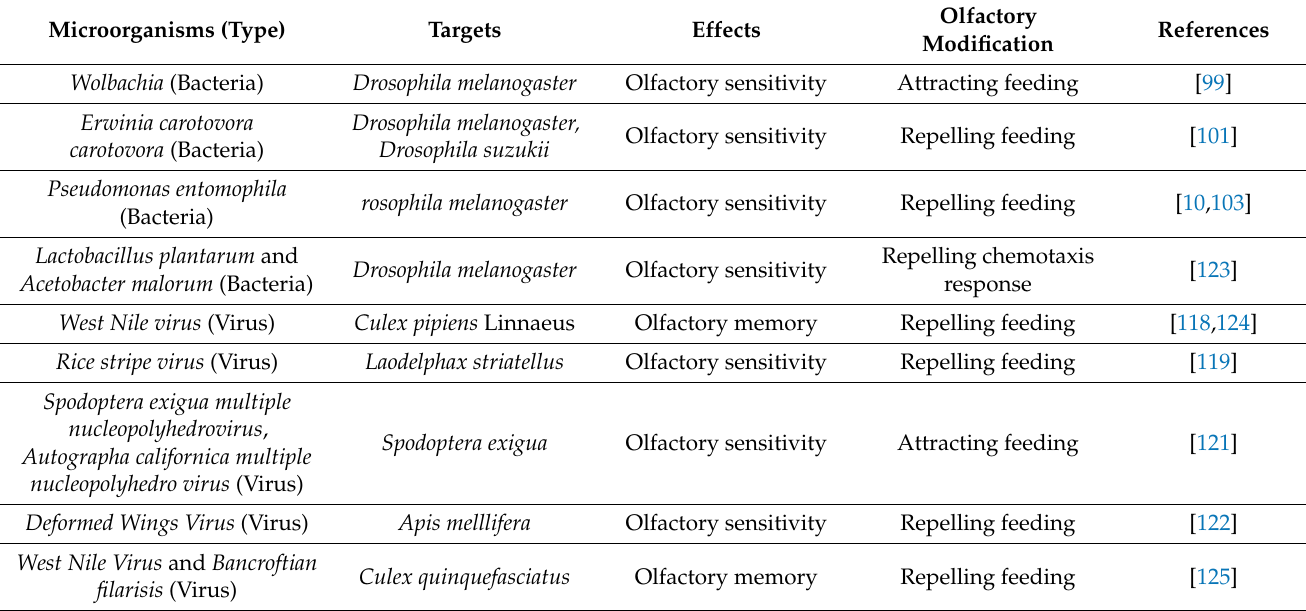
Table 3. Cases of symbiotic microorganism trigger changes in insect behaviors through